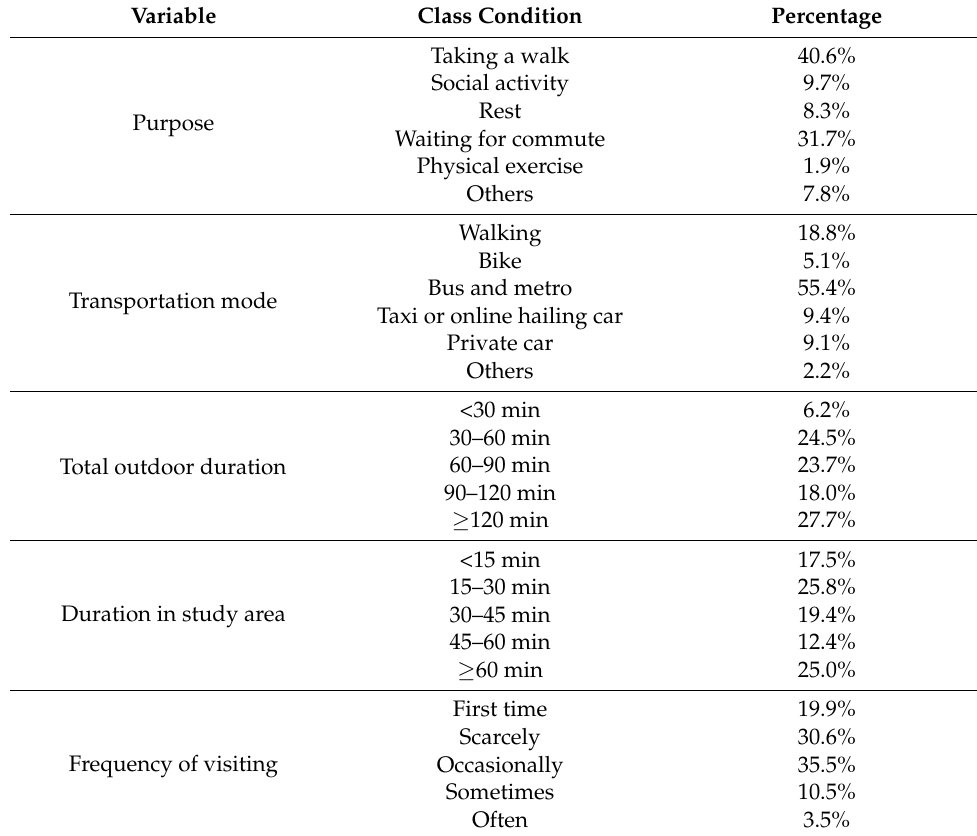
Table 4. Behavioral factors of respondents in